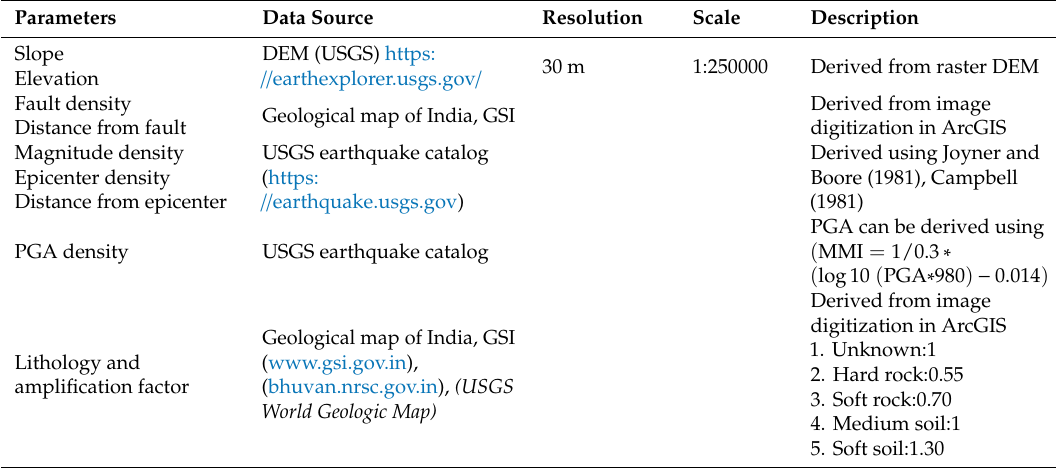
Table 1. Earthquake probability parameters and their